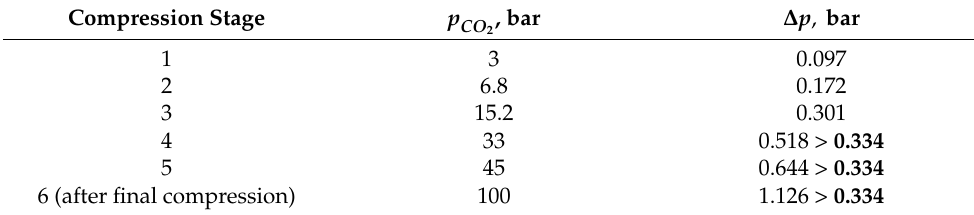
Table 5. The values of obtained acceptable pressure drop across coolers.